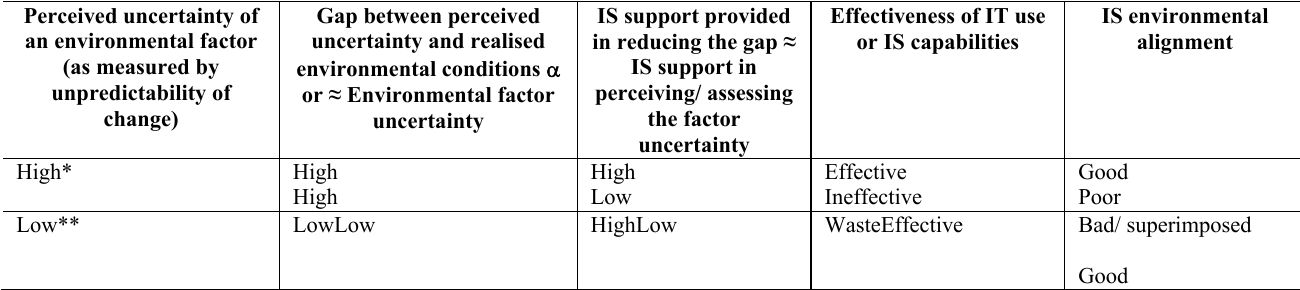
Table 3:Effectiveness of IT use (IS capability) and its implication on IS environmental alignment Perceived uncertainty of an environmental factor (as measured by unpredictability of